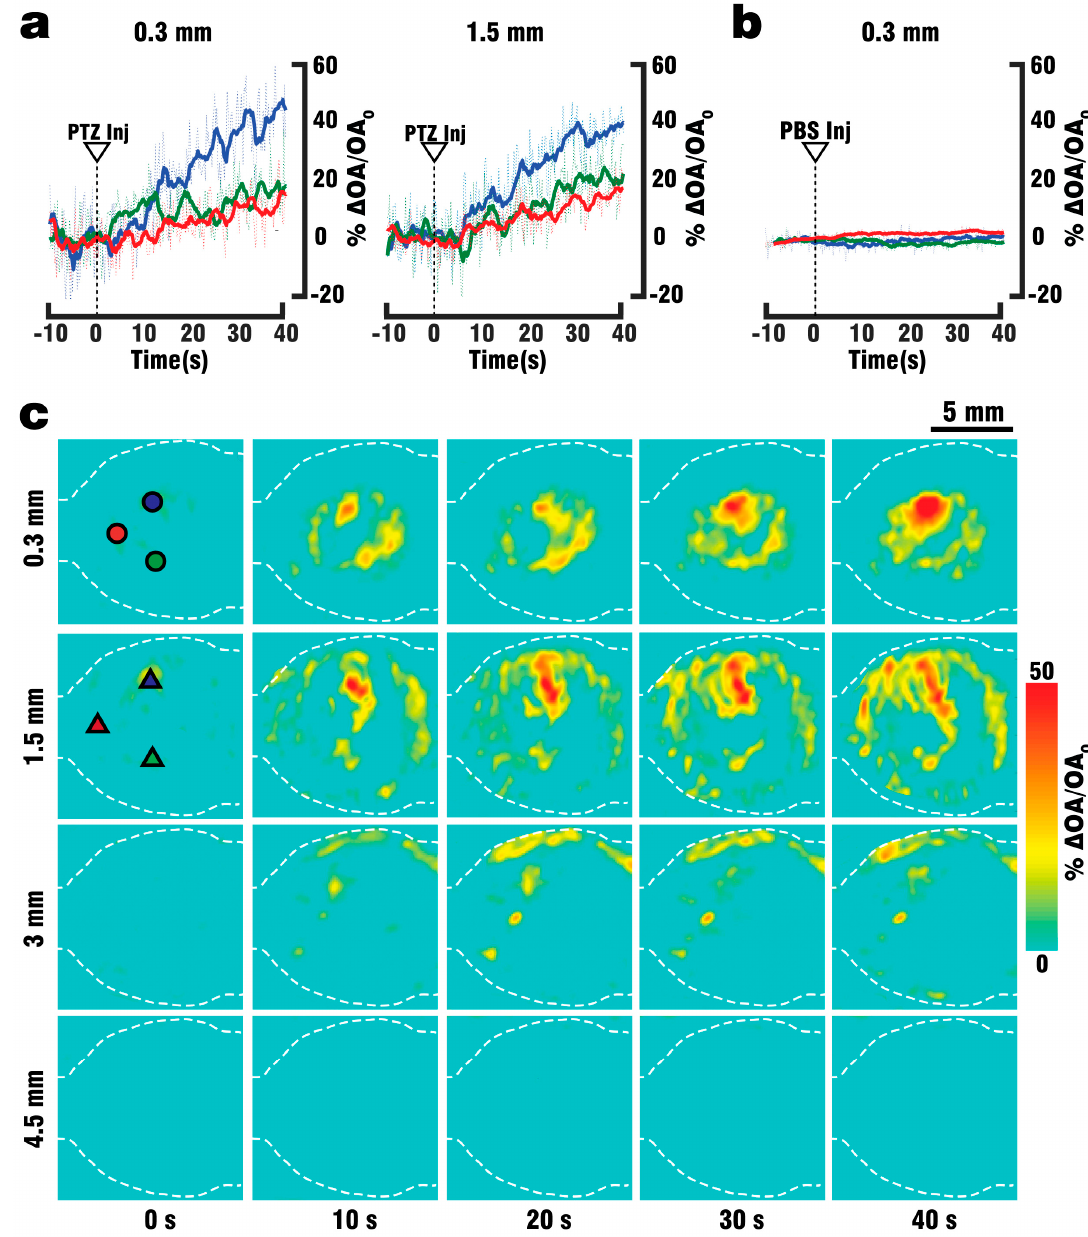
Figure 5. Volumetric FONT imaging of neuronal activation in the perfused GCaMP mouse model at 488 nm. ( a ) Time-traces of the normalized FONT data along with moving averages over 10 image frames are shown from individual voxels at 0.3 and 1.5 mm brain depth—positions are indicated in panel C. ( b ) Normalized, averaged FONT traces at 0.3 mm depth following a PBS injection (control experiment) exhibit no signal changes. ( c ) Temporal progression of the relative FONT signal changes in three representative slices located at depths of 0.3, 1.5, 3 and 4.5 mm in a GCaMP6f-expressing mouse brain. PTZ injection was performed at t = 0.